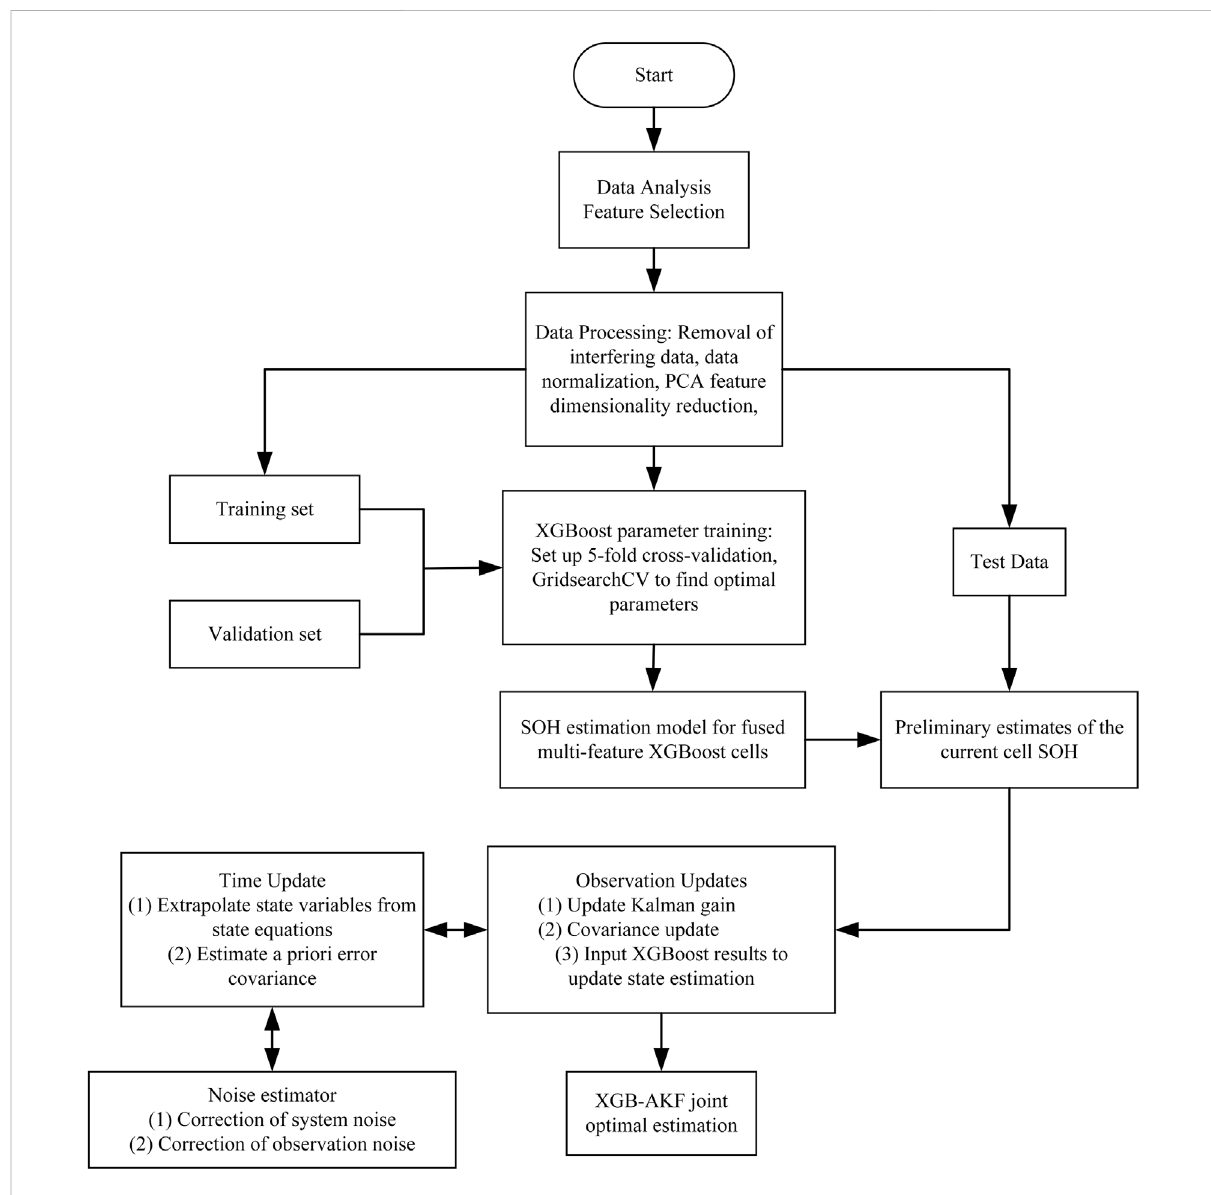
FIGURE 6 XGB-AKF model to estimate SOH framework for Li-ion